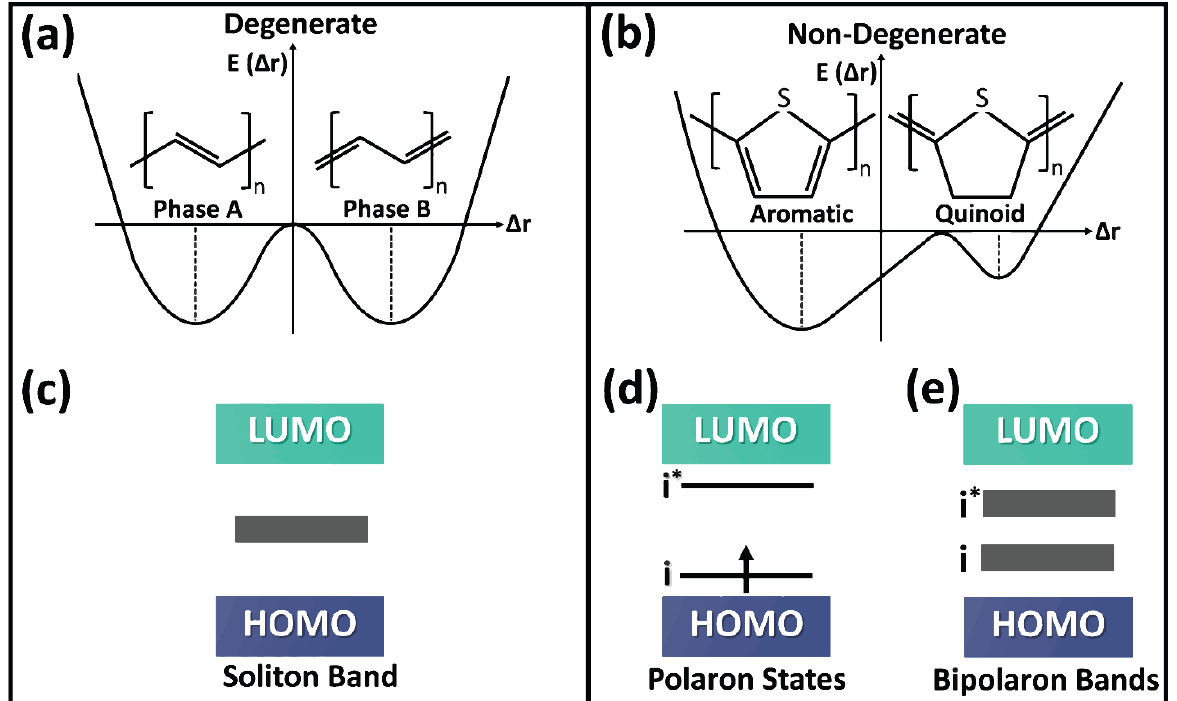
Figure 3. Potential energy (E( ∆ r)) versus the bond length alternation ( ∆ r) for ( a ) a two-fold degenerate ground-state conjugated polymer, such as poly(acetylene), and ( b ) a non-degenerate ground-state conjugated polymer, such as poly(thiophene) [1]. Schematic illustration of energy levels for doped conjugated polymers showing ( c ) the soliton band produced in the degenerate ground-state and ( d ) polaron states and ( e ) bipolaron bands resulting in the non-degenerate ground-state conjugated polymers [1]. It is worth mentioning thIt i and i* are two in-gap states between the HOMO and the LUMO that appear as a consequence of the energy difference of chains on each side of the defect for the non ‐ degenerate ground state. ( a – e ) Reproduced with permission [1]. Copyright 2020, Elsevier.